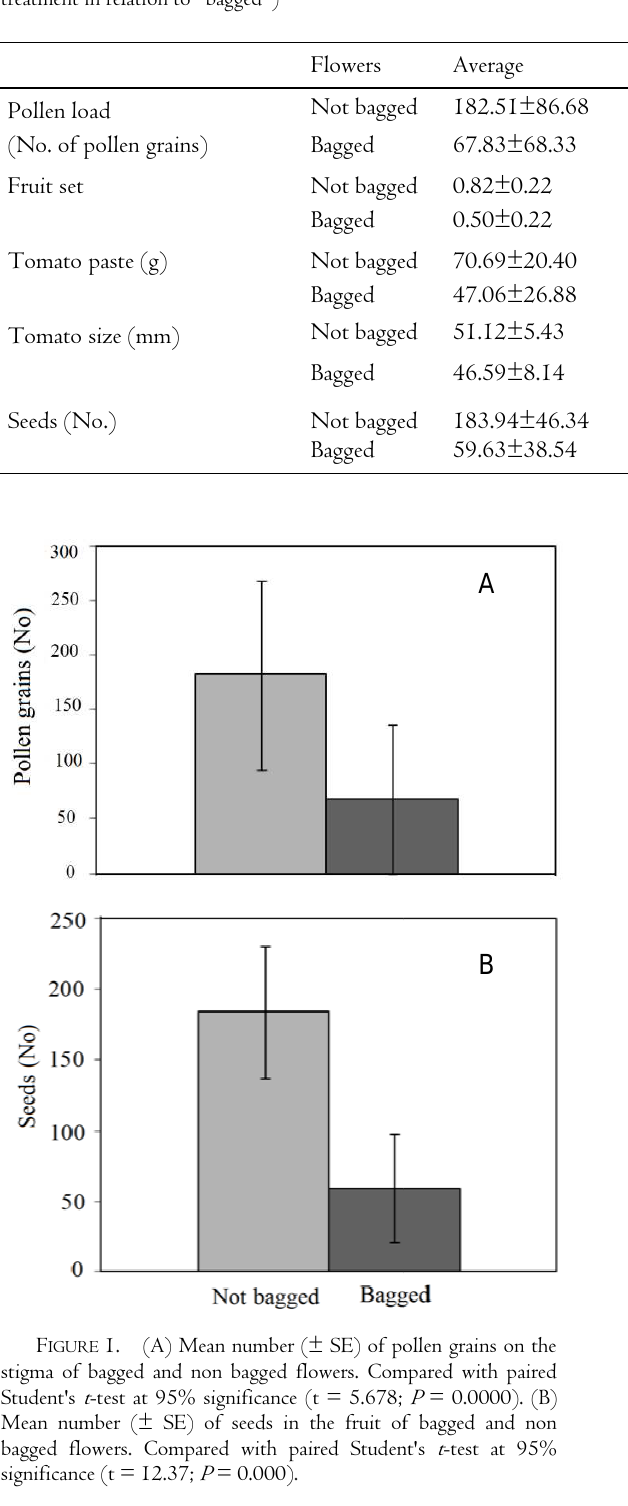
T ABLE 2. Gains in tomato plant crops obtained from bagged and not bagged flowers treatments. Compared with paired Student's t -test 95% significance (N: sample number; t: Student's t test; df: degree of freedom; p: statistical significance; %: Percentage ga